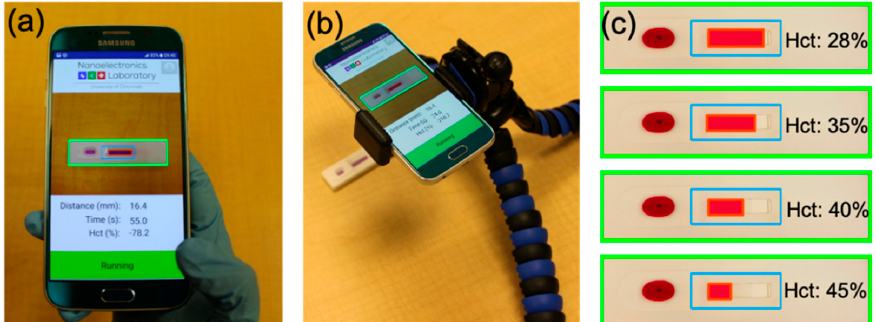
Figure 3. Operation of LFTA on commercial smartphone with fluid flow measurements taken by hand ( a ) and utilizing a smartphone stand ( b ). Illustration of RBC flow distance for different Hct levels after a fixed test time of 150 s ( c ). Reprinted with permission from [25]. Copyright 2020 Else-